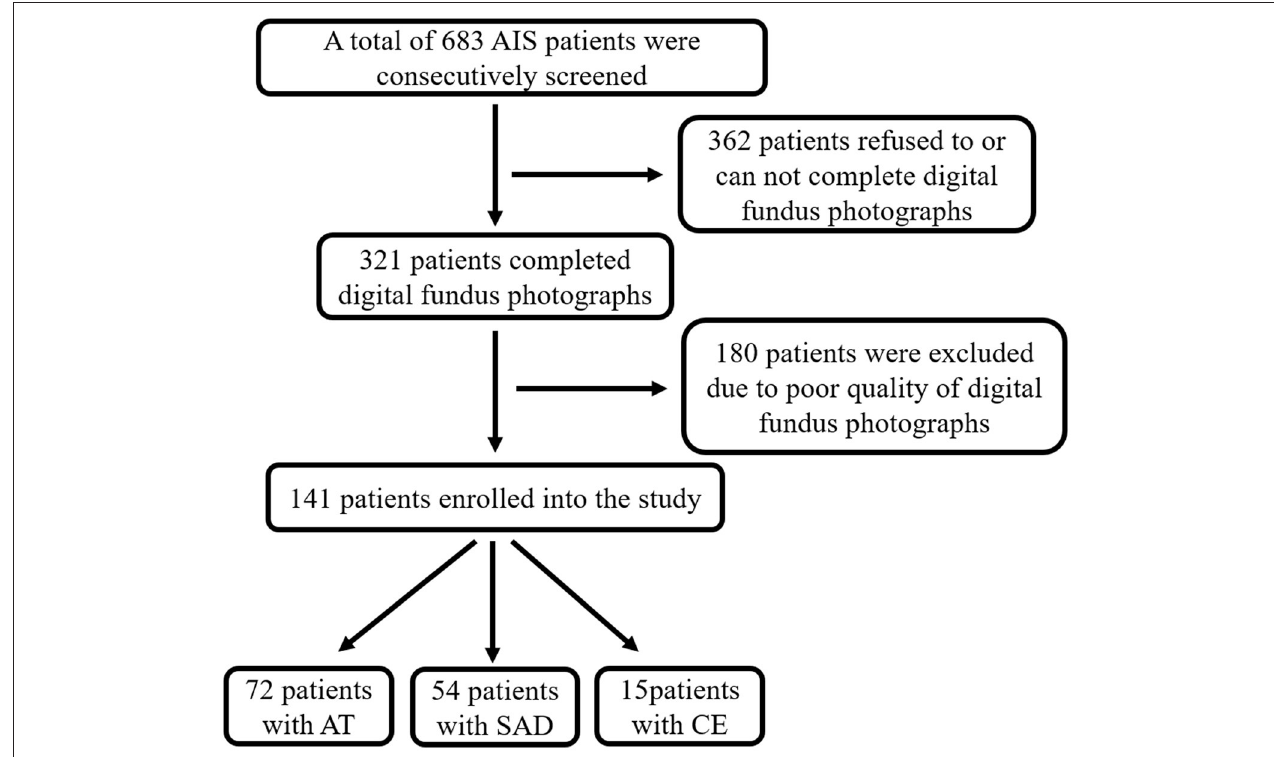
FIGURE 3 | Screening flow chart. AIS, acute ischemic stroke; AT, atherothrombosis; SAD, small artery disease; CE, cardioembolism.